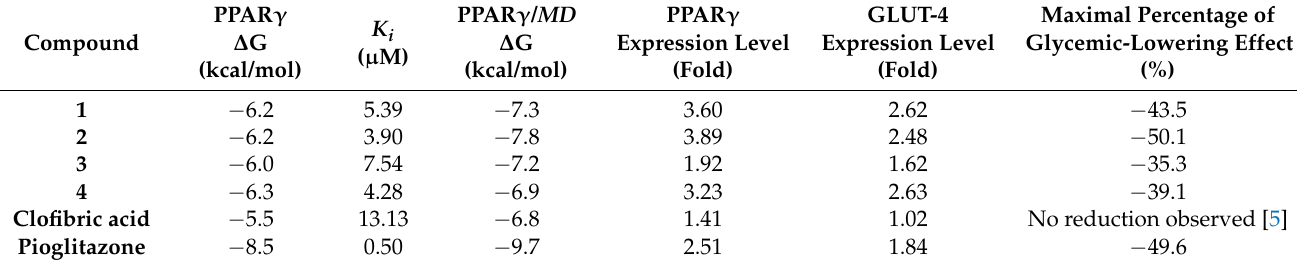
Table 1. Molecular docking binding energies, calculated affinities, molecular dynamics binding ener- gies, and quantitative pharmacological actions for compounds 1 – 4 , clofibric acid, and